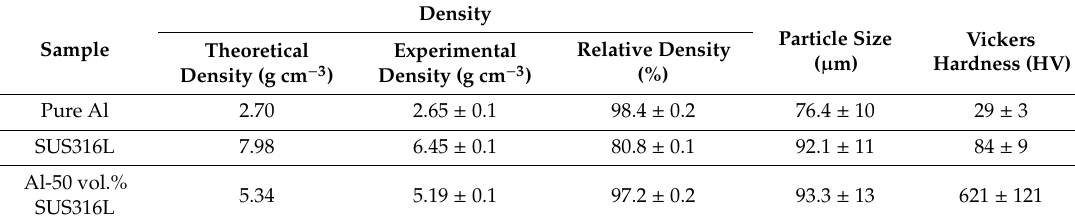
Figure 5. SEM micrographs and EDS analyses of ( a ) pure Al bulk, ( b ) SUS316L bulk, and ( c ) Al-50 vol.% SUS316L composite. Table 3. The physical properties of Al, Ti, and Al-Ti